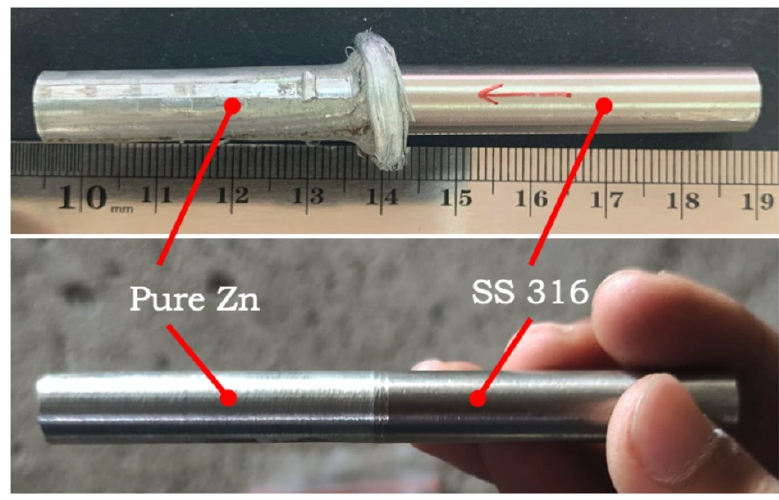
Figure 4. The morphology of the welded joint and removal of flash on sample after friction welding process.